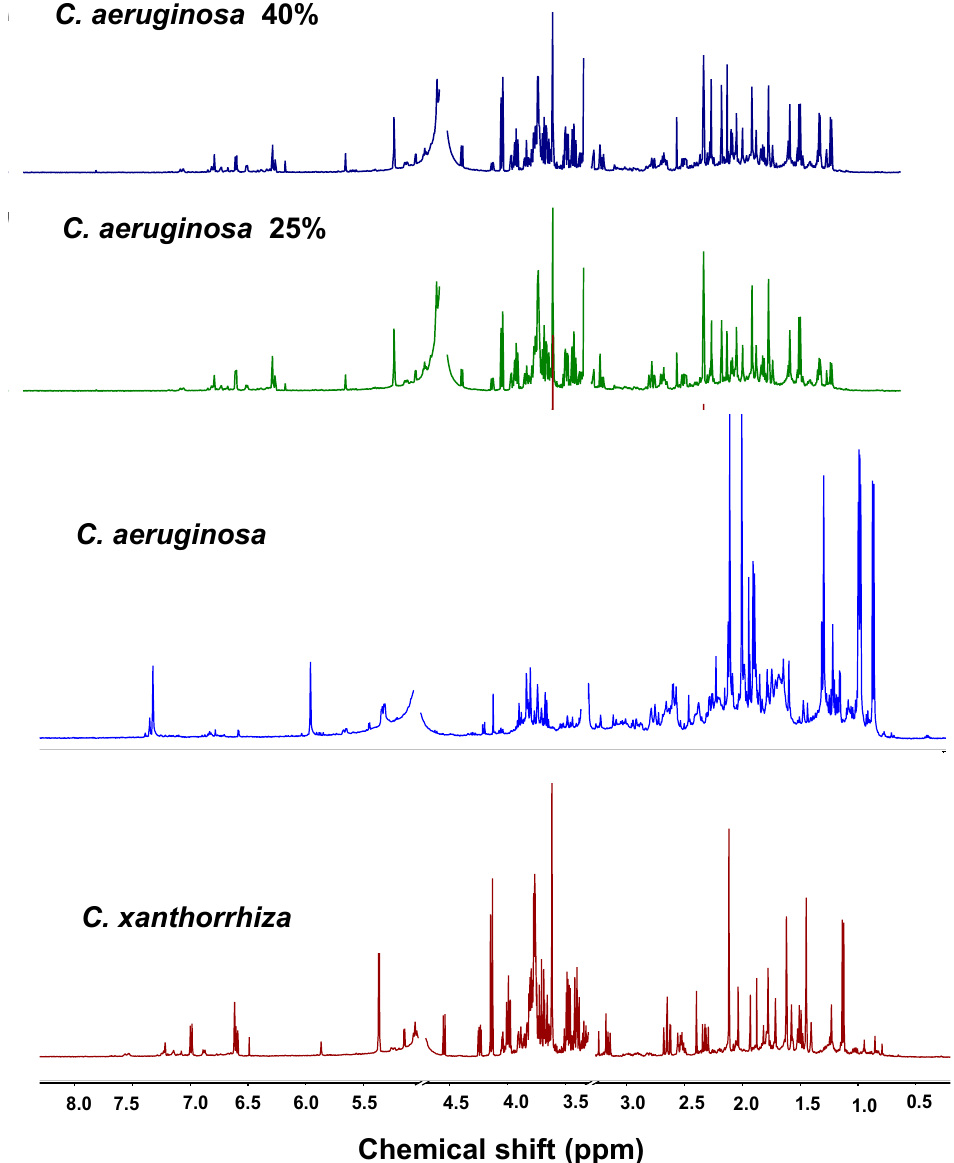
Figure 4. 1 H-NMR spectra of pure C. xanthorrhiza , pure C. aeruginosa , and adulterated C. xanthorrhiza with C. aeruginosa.